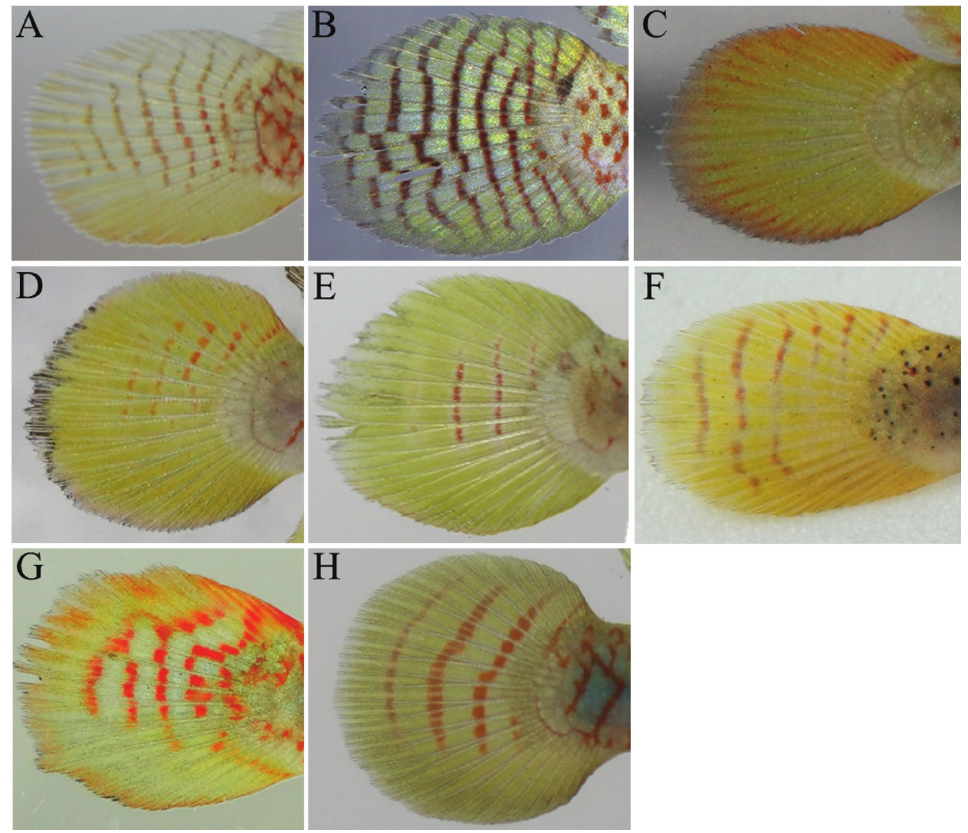
Figure 12. Variation of colour pattern of the caudal fin of males of different species of the Melanorivulus pictus group from Rio Paraná, Brazil. A) M. amambaiensis ; B) M. apiamici ; C) M. egens ; D) M. interruptus ; E) M. ivinhemensis ; F) M. nigropunctatus ; G) M. ofaie ; H) M. scalaris